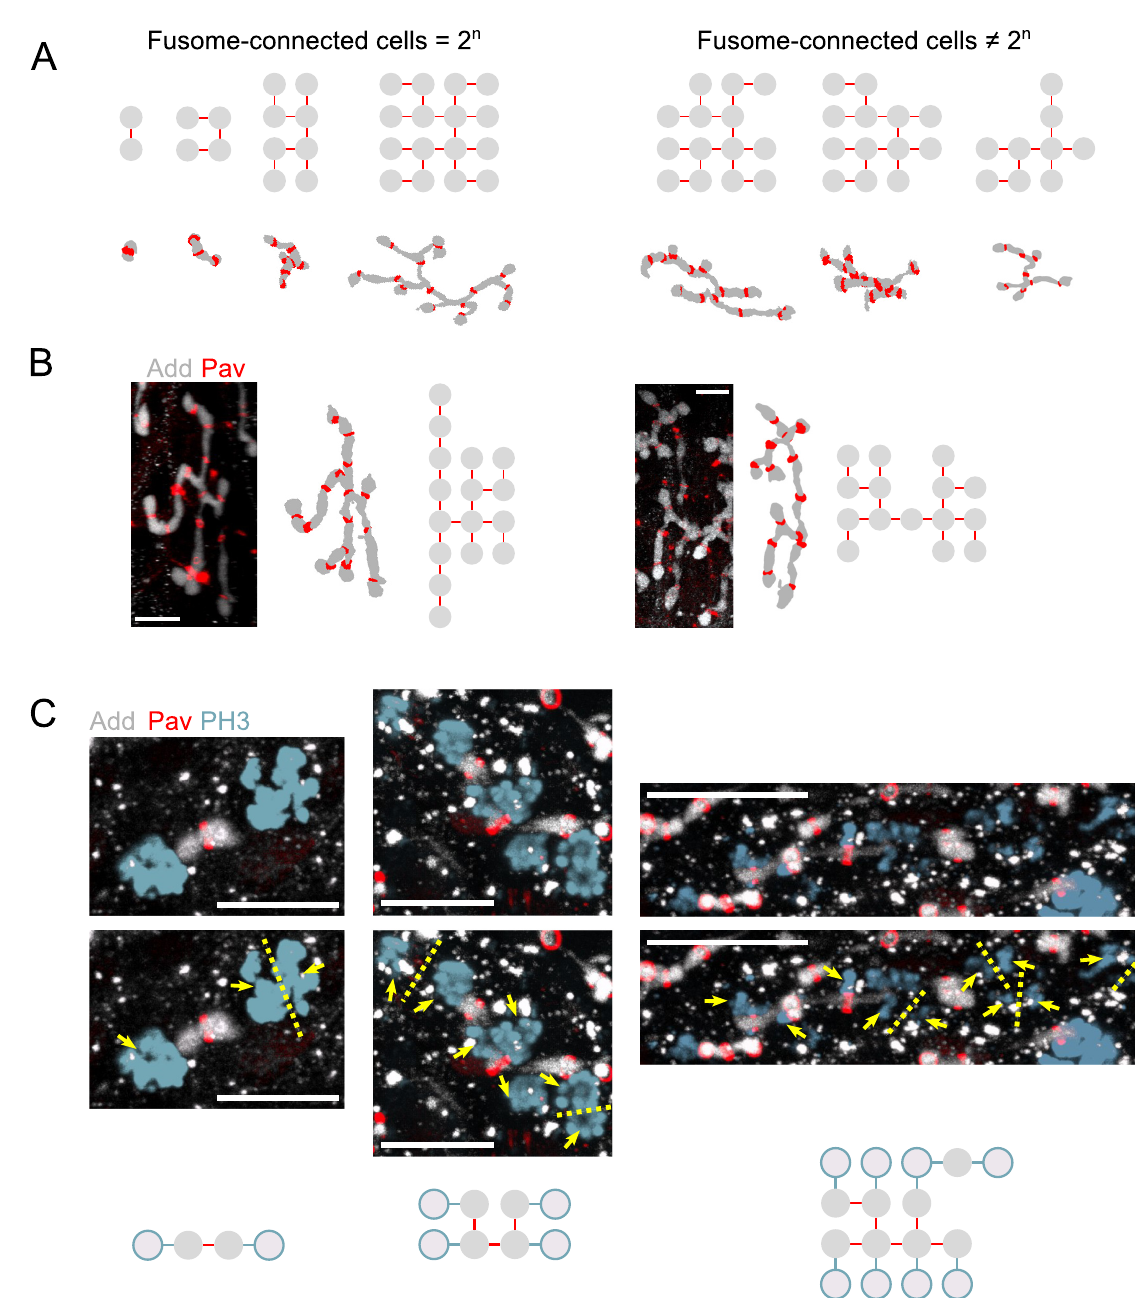
Fig 4. Fusome fragmentation during spermatogenesis and loss of maximal branching. A) Starting with n = 62 reconstructed fusomes, a range of cyst sizes can be inferred by identifying the largest connected portions of fusome within each sample. These fusome portions, and their corresponding ring canals, can be used to identify the number of cells connected by each fusome fragment (fusome-connected cells). In approximately half of these, the number of fusome-connected cells was a power of 2 (n = 31). B) Two examples of fusomes connecting 16 and 15 cells, respectively, whose topology cannot be embedded onto that of a maximally branched network. C) Projections of 3D images of dividing cysts with labeled fusome (Adducin, gray), ring canals (Pav, red), and mitotic chromosomes (Phosphohistone 3, cyan), showing examples of a 2-cell (left), 4-cell (middle), and 8-cell cyst (right) during mitosis. In at least one location in the 8-cell cyst, cells are dividing without forming a new branch; as such, the resulting 16-cell tree will not possess a maximally-branch topology. In all examples, yellow dotted lines denote the likely plane of division for actively dividing cells, while yellow arrows depict clear bundles of aggregated or migrating chromosomes. In addition, nodes representing the locations of existing cells, as well as the likely positions of newly-formed cell based on the plane of division are shown. Scale bars = 10 μ